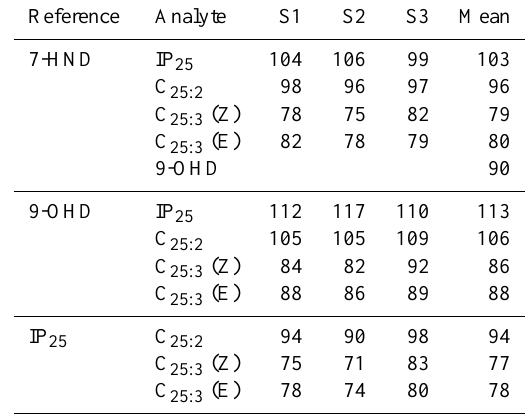
Table 6. Relative concentrations of biomarkers measured against 2 internal standards (7-HND & 9-OHD) and IP 25 using different ex- traction methods – Accelerated Solvent Extraction (ASE) and soni- cation (SON). Values correspond to the ratios of mean values (from triplicates) of each Analyte/Reference derived from each method expressed as a percentage – i.e. [mean (ASE)/mean (SON)] ×